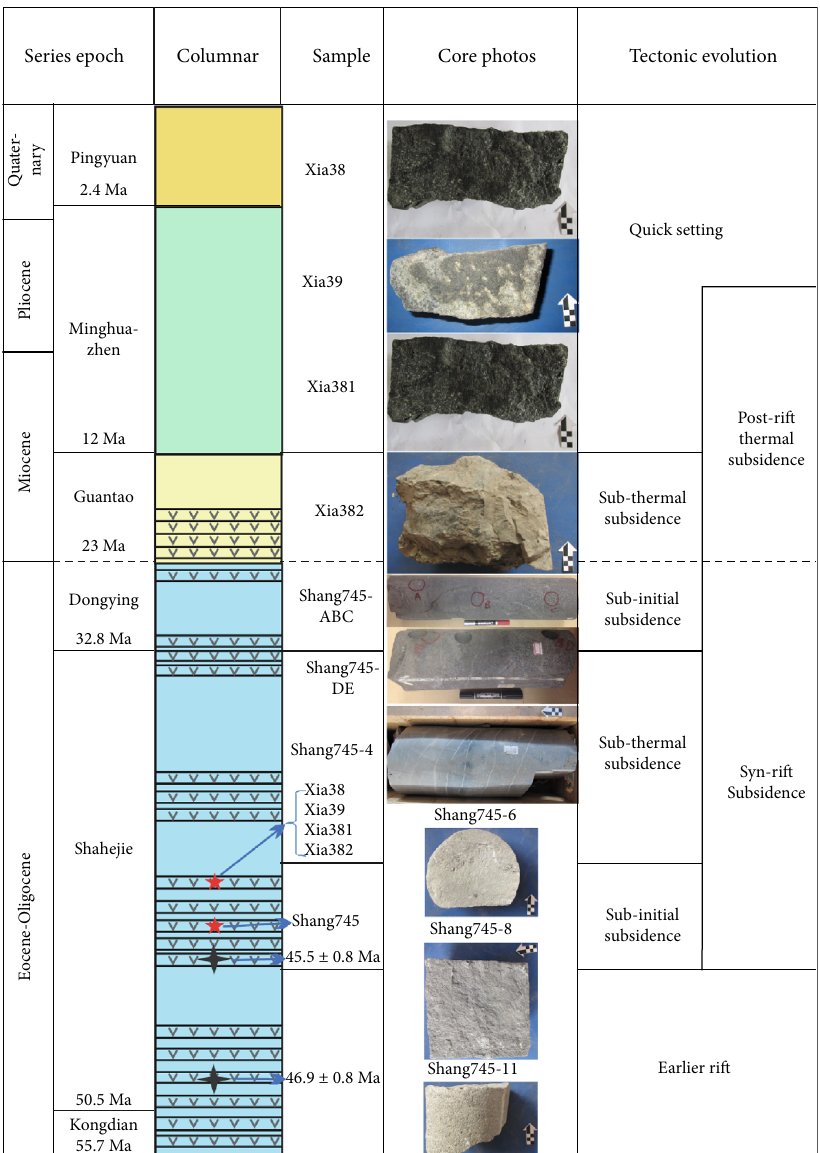
Figure 2: Cenozoic strata column of the Bohai Bay Basin with summary of the tectonic evolution and 40 Ar- 39 Ar age data for basalts from the Shahejie Formation in the Jiyang Depression (modi fi ed after [56]), showing sample